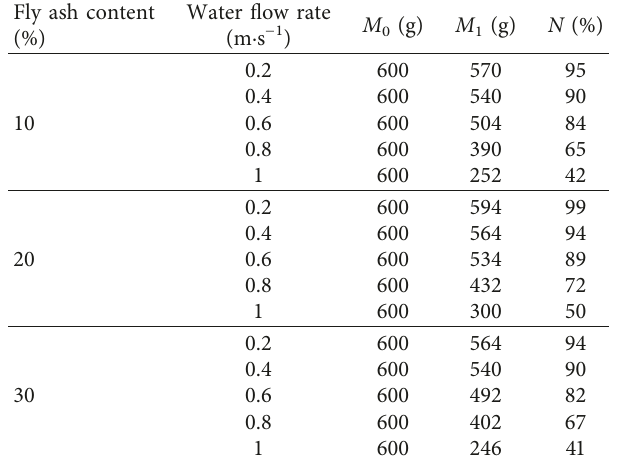
Table 3: Stone retention rate varies with water flow rate. Fly ash content Water flow (%)